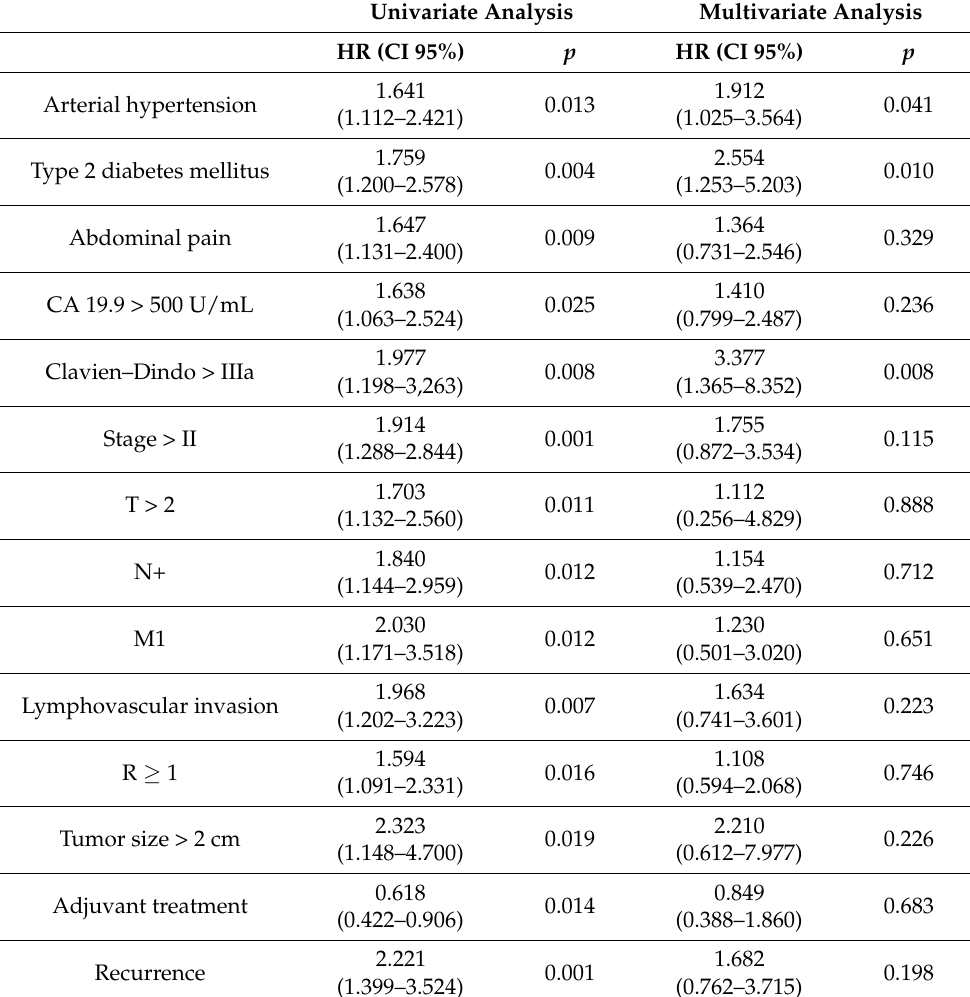
Table 2. Prognostic factors for overall survival in PDAC patients. Abbreviations—CA 19.9: carbohy- drate antigen 19.9; HR: hazard ratio; M: metastasis; N: lymph nodes; R: resection margin; T: tumor. Overall survival calculated from the date of surgery to the date of death or of data